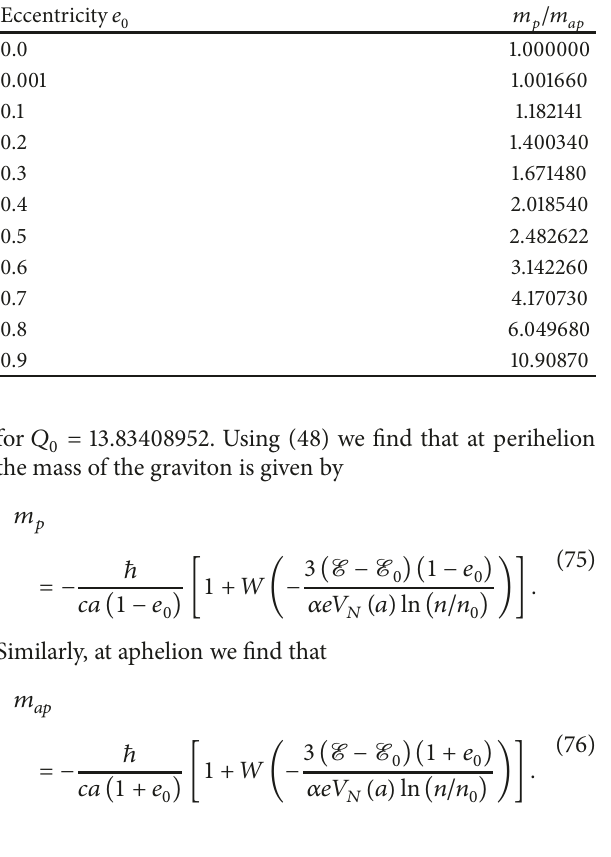
Table 4: Ratio 𝑚 𝑝 /𝑚 𝑎𝑝 of the mediating the interaction graviton as a function of various eccentricities as is “felt” by the orbiting secondary body 𝑄 0 = 138.326 between perihelion and aphelion